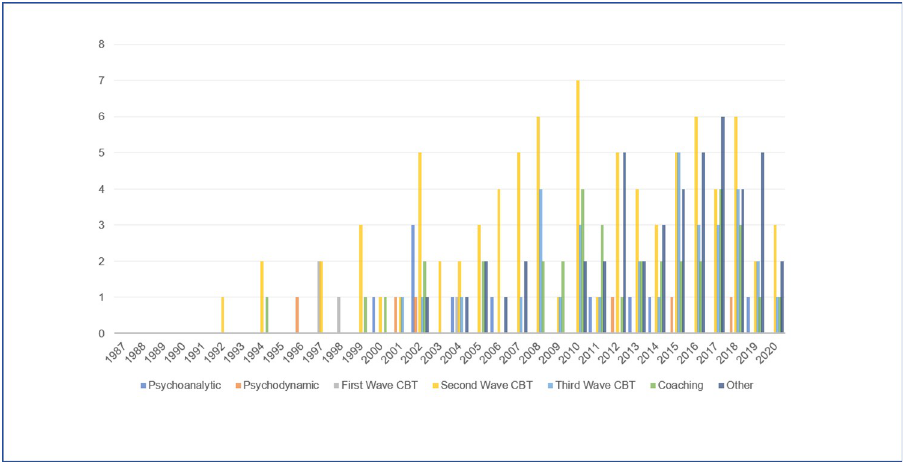
Fig 3. ADHD interventions published by